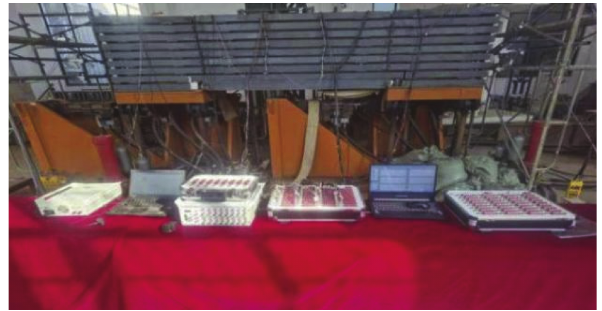
Figure 1: Multipoint seismic excitation vibration array